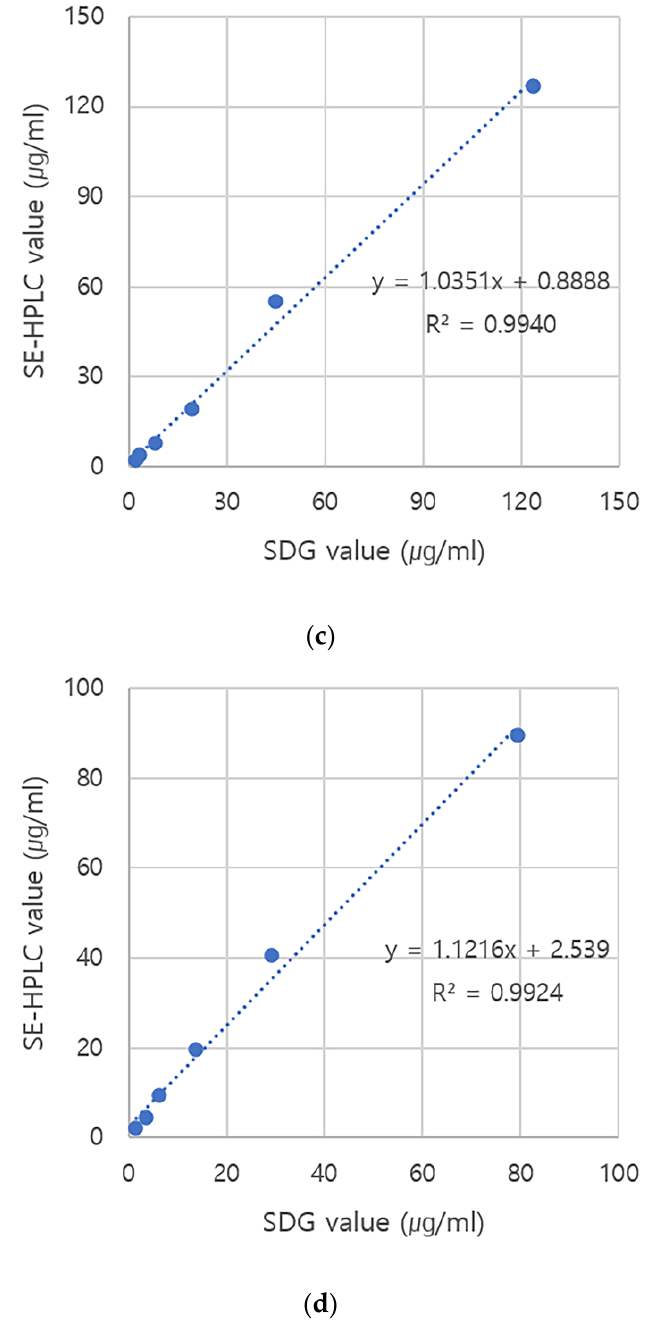
Figure 1. Differences in the amount of 146S particles obtained from SDG and SE-HPLC. ( a ) Correla- tion between the 146S particle quantity of FMDV O PA2 measured by SDG and that measured by SE-HPLC. ( b ) Correlation between the 146S particle quantity of FMDV O BE measured by SDG and that measured by SE-HPLC. ( c ) Correlation between the 146S particle quantity of FMDV A22 IRQ measured by SDG and that measured by SE-HPLC. ( d ) Correlation between the 146S particle quantity of FMDV A YC measured by SDG and that measured by SE-HPLC. Abbreviations: SDG, sucrose density gradient ultracentrifugation; SE-HPLC, size-exclusion high-performance liquid chromatog- raphy.